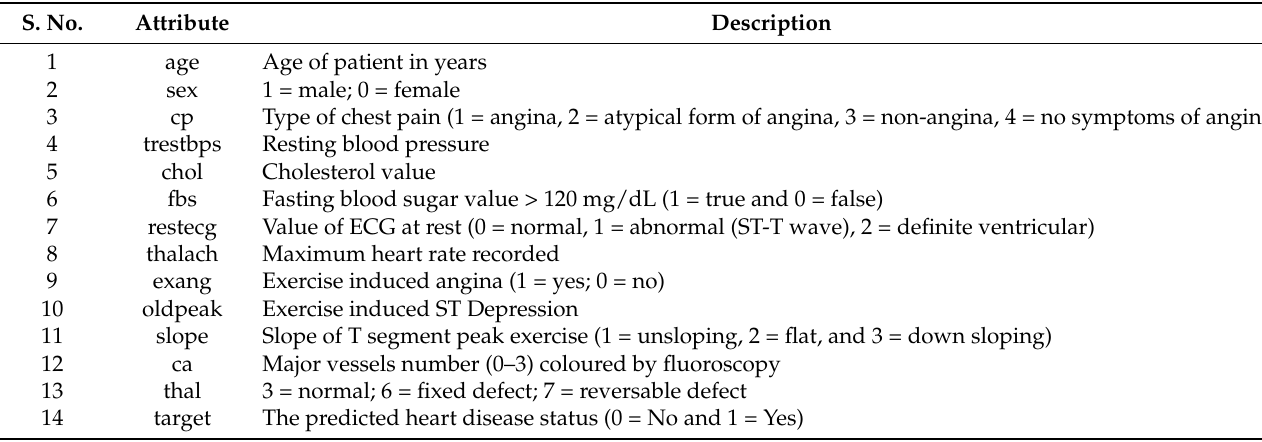
Table 1. Attribute